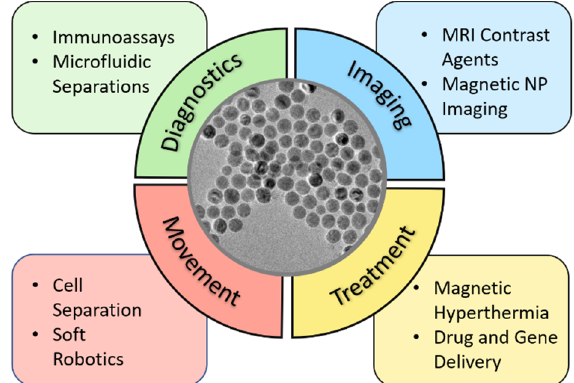
Figure 1. The applications of magnetic particles can be classified into four categories depending on the aim of the technology. Imaging and in vitro diagnostics are mature areas that have clinical relevance, while research into magnetic particles to treat disease or affect controlled motion of larger organelles, cells and biomaterials is at the pre-clinical stage. Abbreviations: Magnetic Resonance Imaging (MRI), Magnetic Nanoparticle (NP) Imaging Inset picture provided by Zhen Xiao, iron oxide (magnetite) nanocrystals d = 23 ± 2 nm.